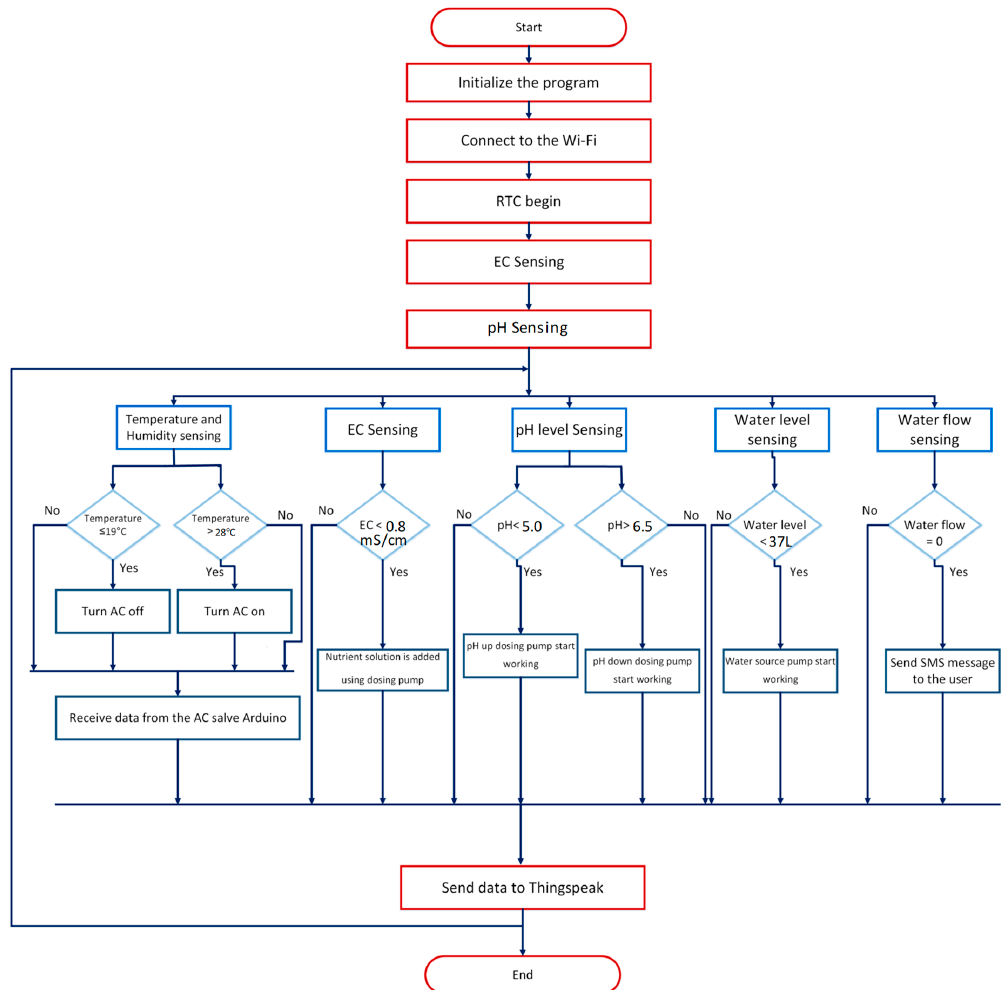
Figure 8. Flowchart of the automatic hydroponic system .